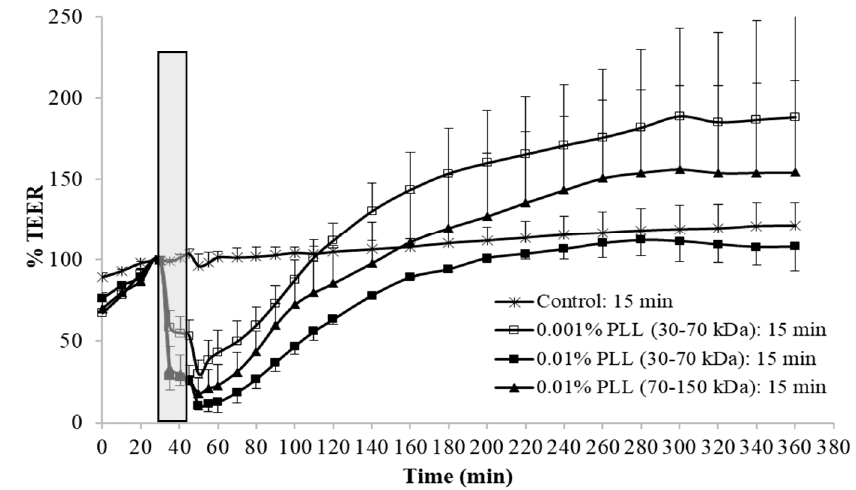
Figure 3. Average values and standard deviations of relative TEER of the urothelium exposed for 15 min to 0.001% or 0.01% poly-L-lysine (PLL) with a molecular weight of 30–70 kDa or 70–150 kDa. At each experimental condition, measurements were performed on urinary bladders of three to four different animals. Exposure time to PLL is marked gray.